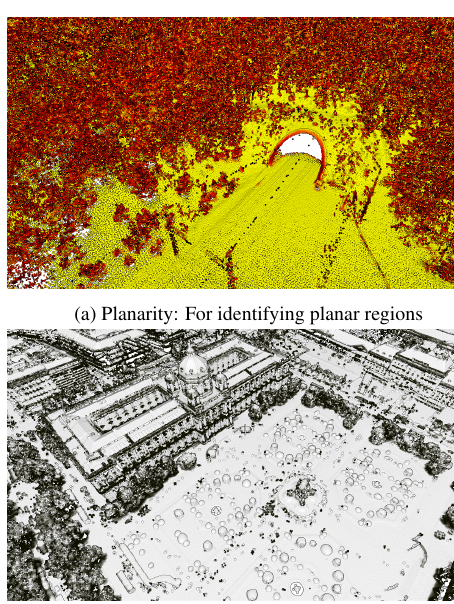
Table 4. Loading [mm:ss] and Switching Attribute [s] duration for LAS/LAZ files with extended attributes. 1 Hand stopped. 2 Out of memory. 3 Hierarchical Structure Generator only.